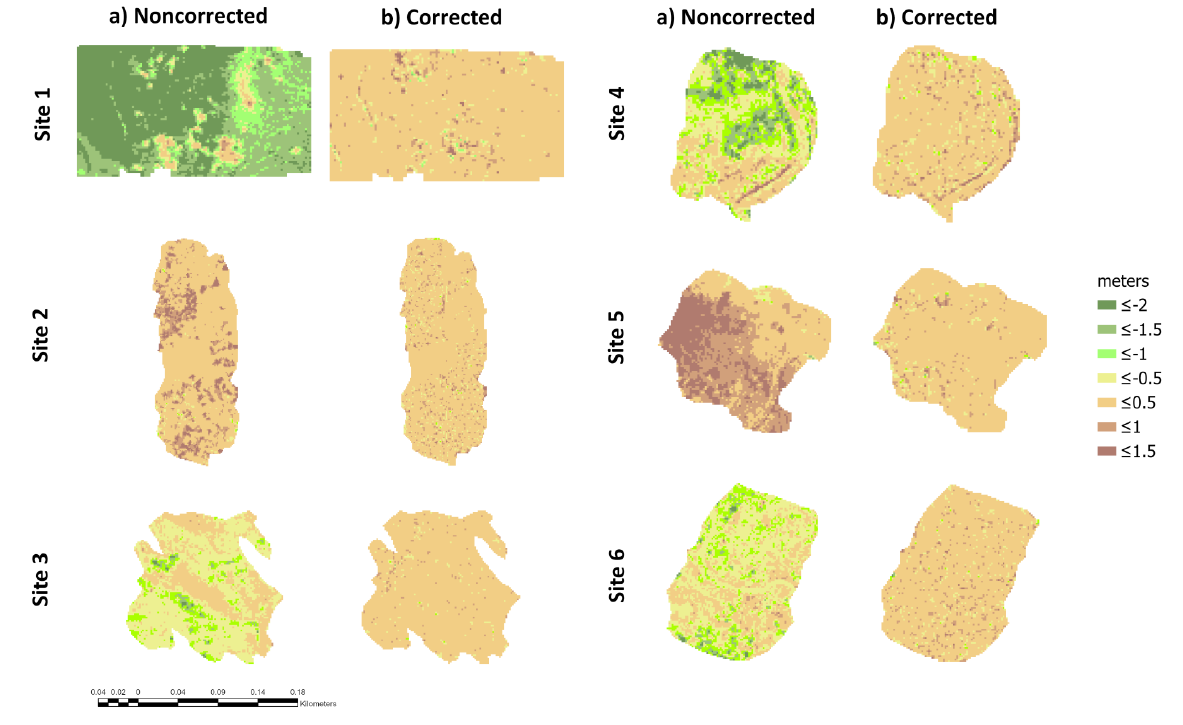
Figure 4. Elevation differences (in meters) before ( a ) and after ( b ) correction using the best classifica- tion filter. In sites 1, 4 and 6: TIN densification algorithm with Siose Forest settings (TIN-SF); in site 2, the progressive morphological filter (PMF) and in sites 3 and 5, the TIN densification algorithm with default settings (DEF). For all sites, the TIN interpolation method and 5 m spatial resolution was kept constant. Maps are shown at 2 m spatial resolution for better interpretation.